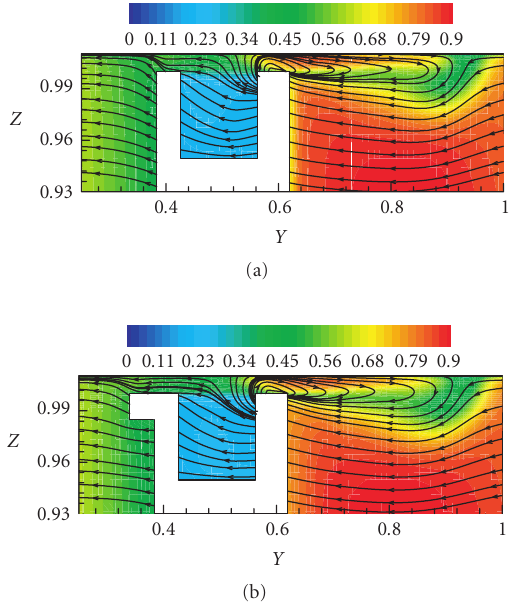
Figure 13: Secondary flow distribution superimposed on the Mach number contour at a streamwise location of 60% from leading wall of the blade, (a) baseline squealer tip and (b) desensitized squealer